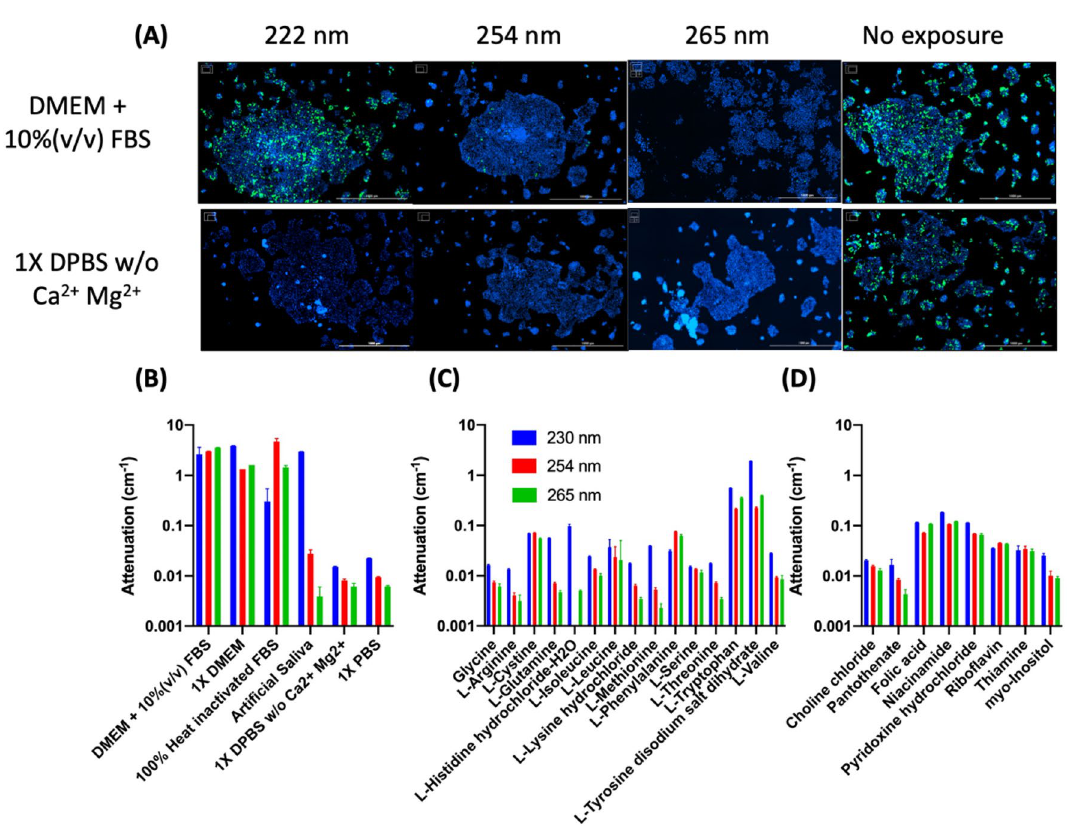
Figure 3. Effect of a medium on UVC virus disinfection. ( A ) Comparison of virus inactivation under different wavelengths (222 nm, 254 nm, and 265 nm) of UVC irradiation. A portion of 300 µL of lentivirus suspension in either DMEM + 10%(v/v) FBS (top panel) or DPBS without calcium or magnesium (bottom panel) was exposed to 4 J/cm 2 of either 222, 254 or 265 nm UV light. Scale bar: 1000 µm. ( B ) Attenuation coefficient for suspension liquids used in UVC experiments. Attenuation coefficients for ( C ) amino acids and ( D ) vitamins in DMEM